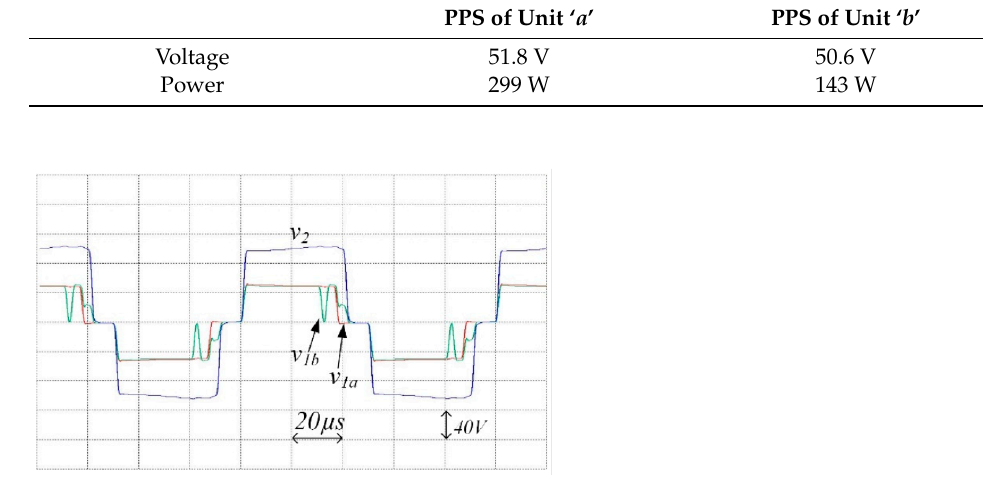
Figure 14. Voltages across windings of the proposed system fed from PPSs emulating PV